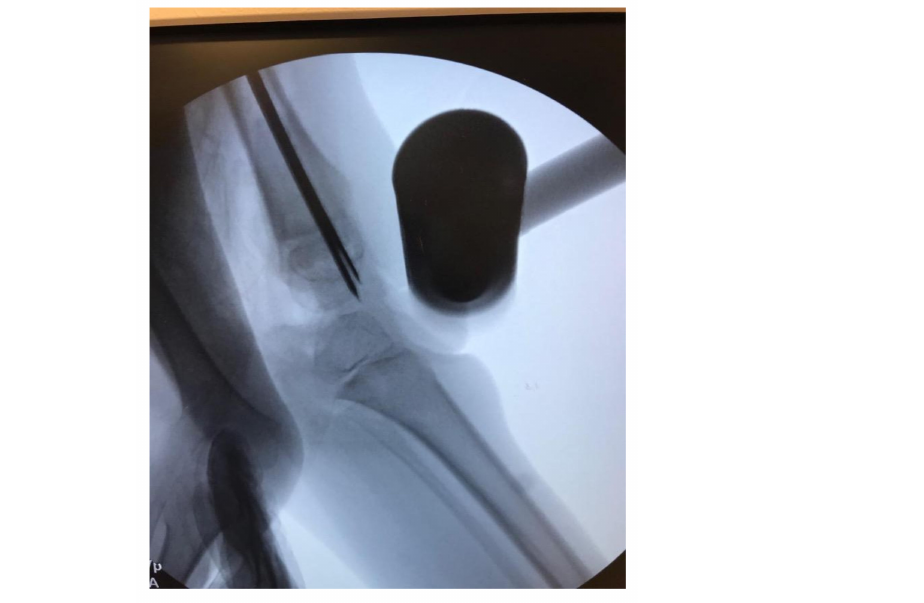
Figure 8. Fluoroscopic view of the knee in max extension after the proximal osteotomy; notice the wires and rod crossing the physis to protect it while the knee is extended.